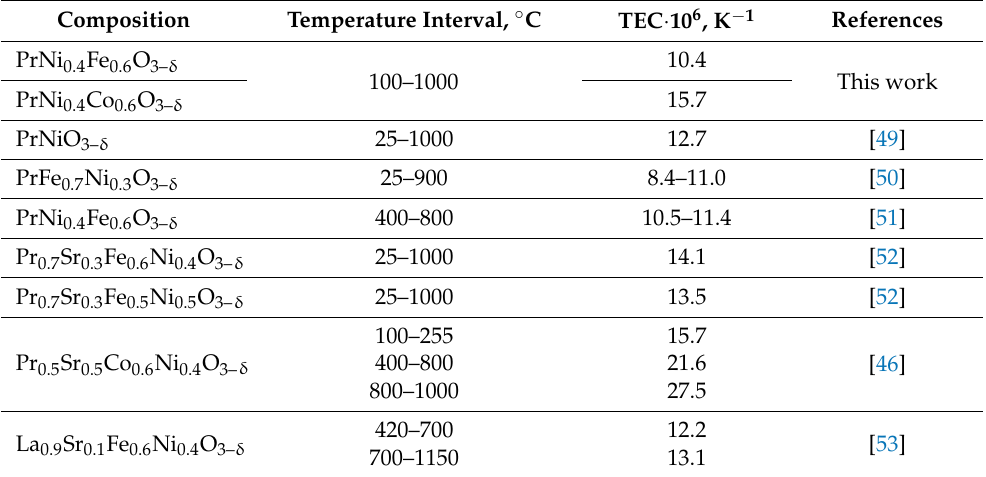
Table 2. Comparative analysis of the TEC values for Pr- and Ni-containing cathode